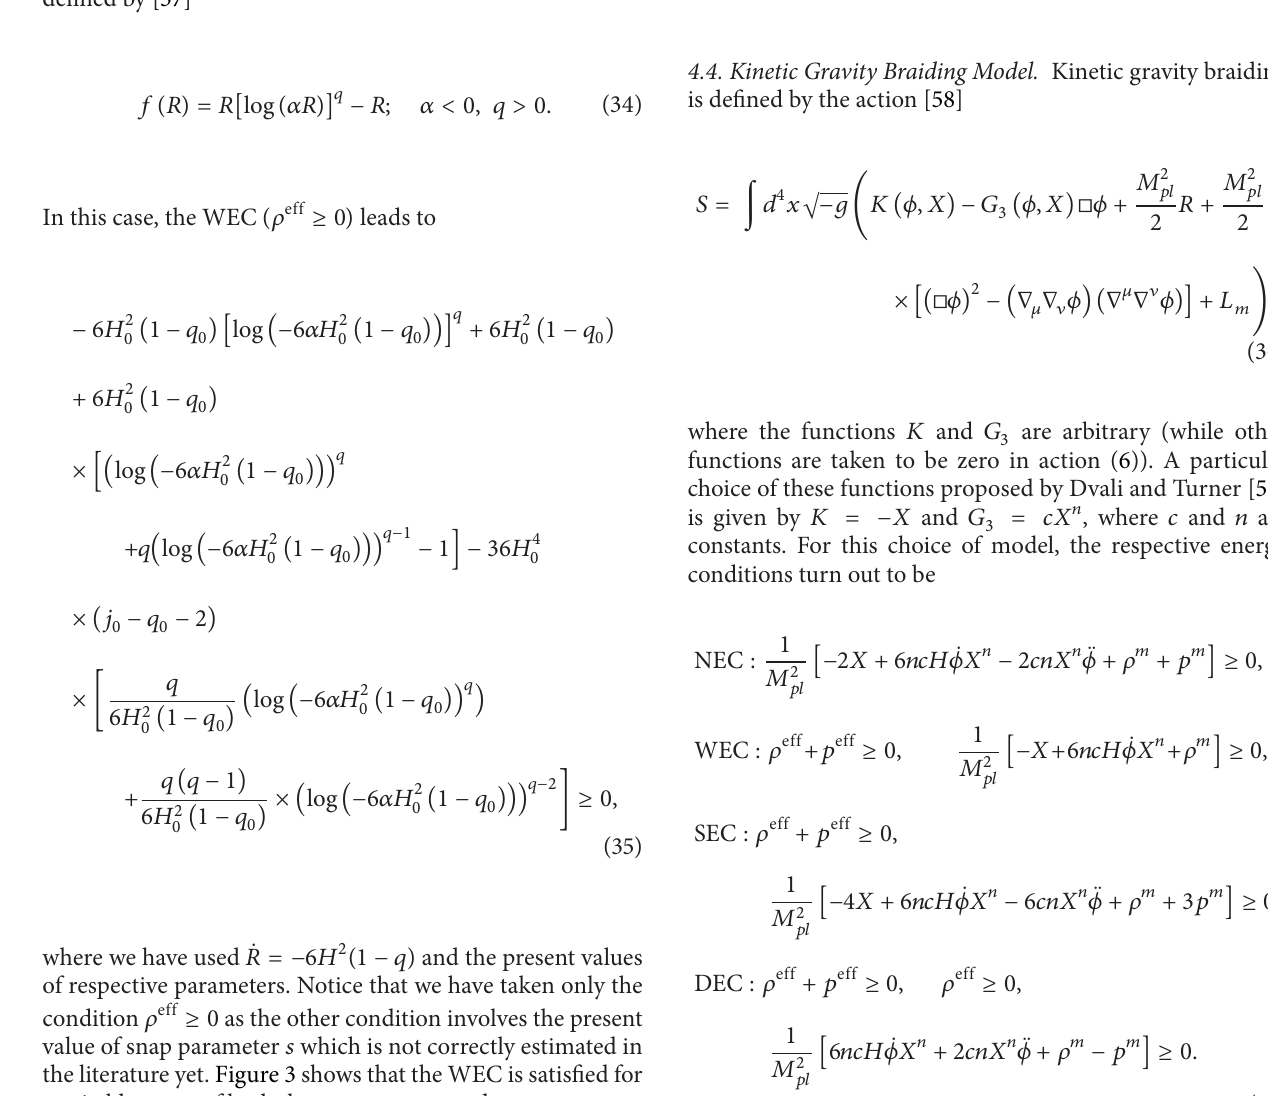
Figure 3: Plot shows WEC versus free parameters 𝑞 and 𝛼 . Here we take 𝑞 0 = −0.64 , 𝐻 0 = 0.718 , and 𝑗 0 = 1.41